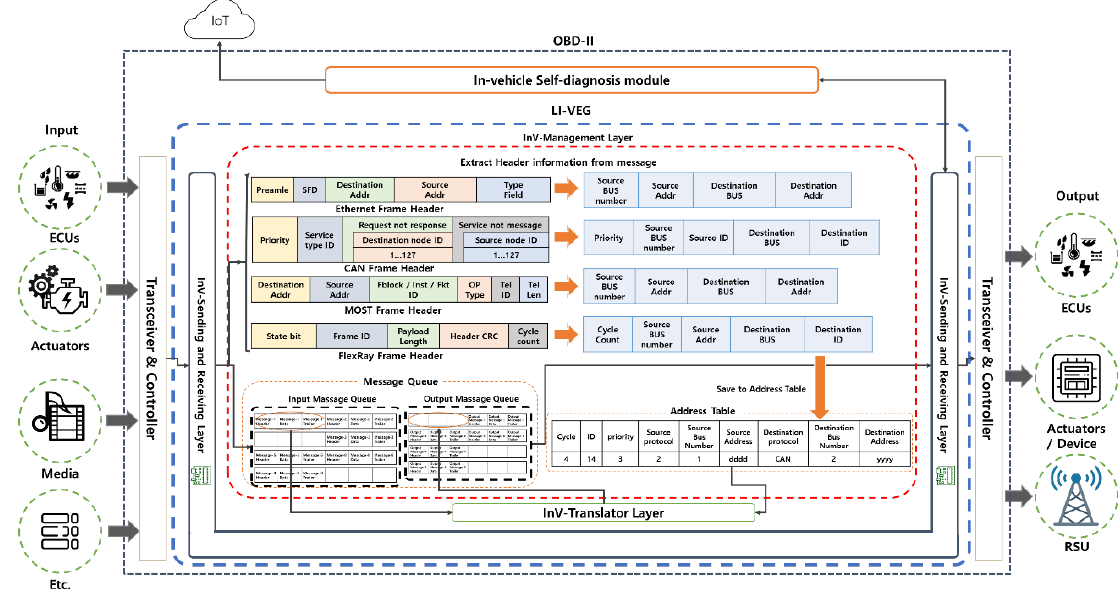
Figure 5. The movement of messages in InV-ML.